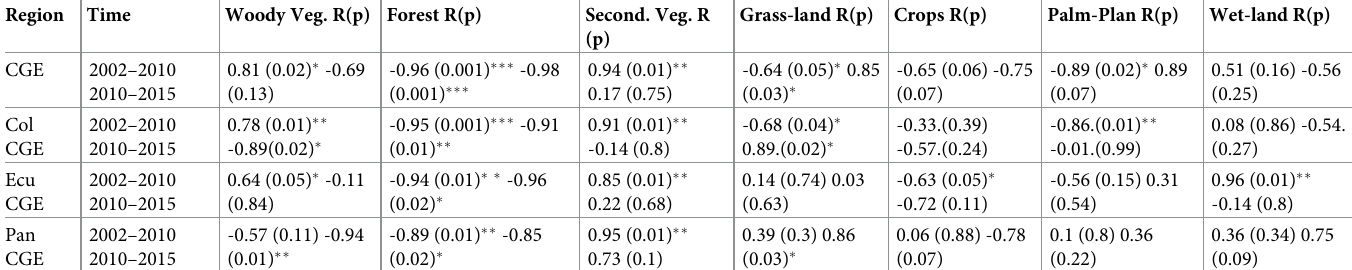
Table 1. Correlations of land-use and land-cover (LULC) change trends among administrative divisions; The Choco´-Darien Global Ecoregion (CGE), Colombian CGE (Col CGE), Ecuadorian CGE (Ecu CGE), and Panamanian CGE (Pan CGE). Pearson’s correlation coefficient (R) are shown for two time periods 2002–2010 and